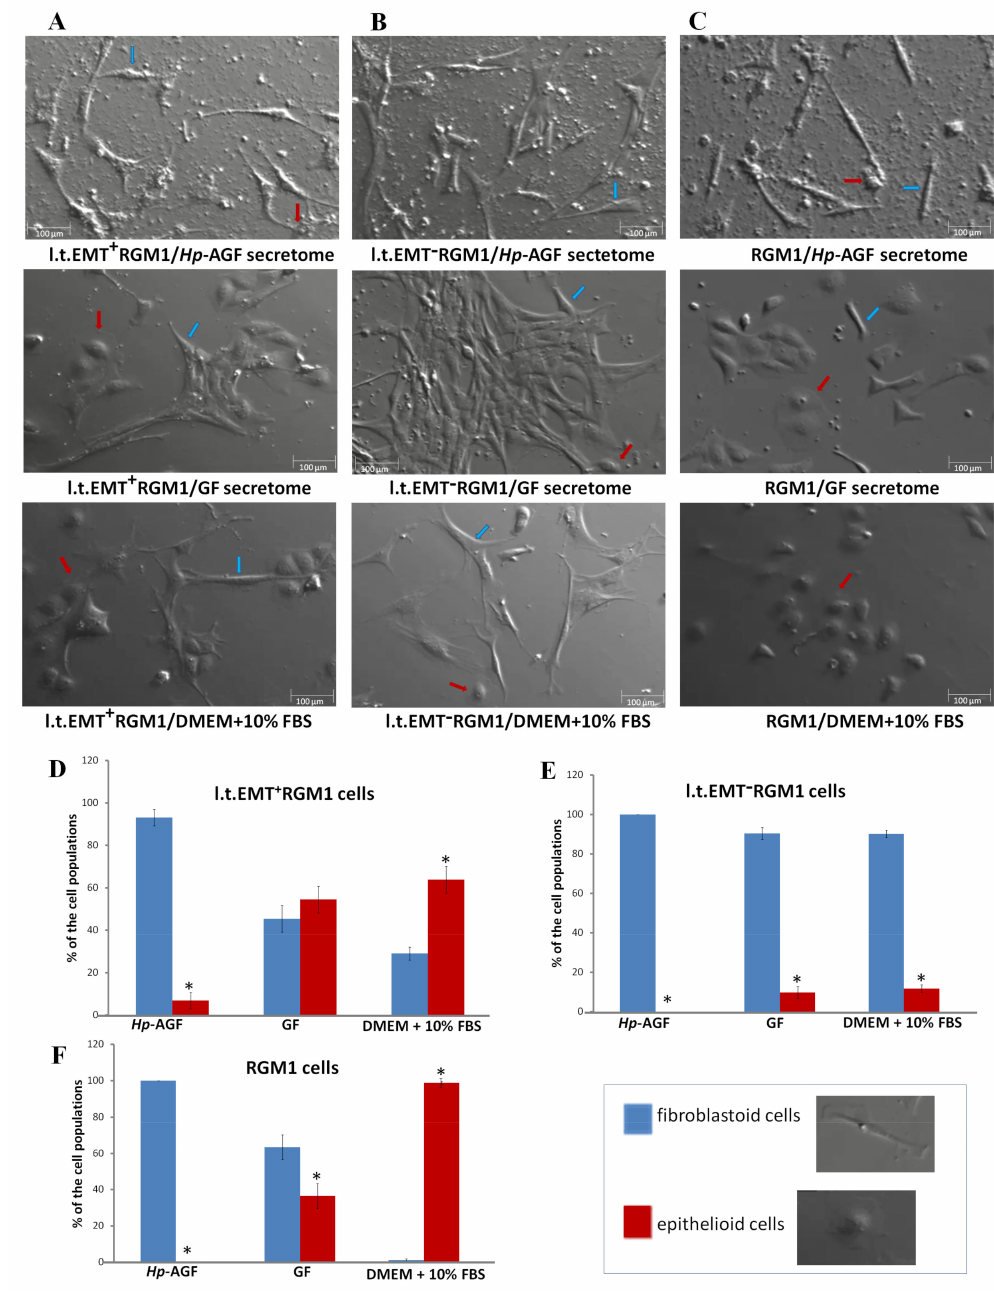
Figure 2. The phenotypical plasticity of l.t.EMT + RGM1 cells. Nomarski contrast of the stability of phenotype of ( A ) l.t.EMT + RGM1 cells placed in Hp -AGF secretome, GF secretome, and DMEM + 10% FBS, respectively; ( B ) l.t.EMT − RGM1 cells placed for 24 h in Hp -AGF secretome, GF secretome, and DMEM + 10% FBS, respectively; ( C ) and of RGM1 cells placed for 24 h in Hp -AGF secretome, GF secretome, and DMEM + 10% FBS, respectively. L.t.EMT + RGM1 cells were characterized by plastic phenotype which depended on the type of the medium suggesting EMT / MET switch ability. L.t.EMT - RGM1 cells cultured for 24 h in DMEM + 10% FBS possessed stable, fibroblastoid-like phenotype in all tested media. Histogram analysis of morphological cell diversity in ( D ) l.t.EMT + RGM1 cellsplacedin Hp -AGFsecretome, GFsecretome, andDMEM + 10%FBS,respectively; ( E )l.t.EMT − RGM1 cells placed for 24 h in Hp -AGF secretome, GF secretome, and DMEM + 10% FBS, respectively; ( F ) and of RGM1 cells placed for 24 h in Hp -AGF secretome, GF secretome, and DMEM + 10% FBS,